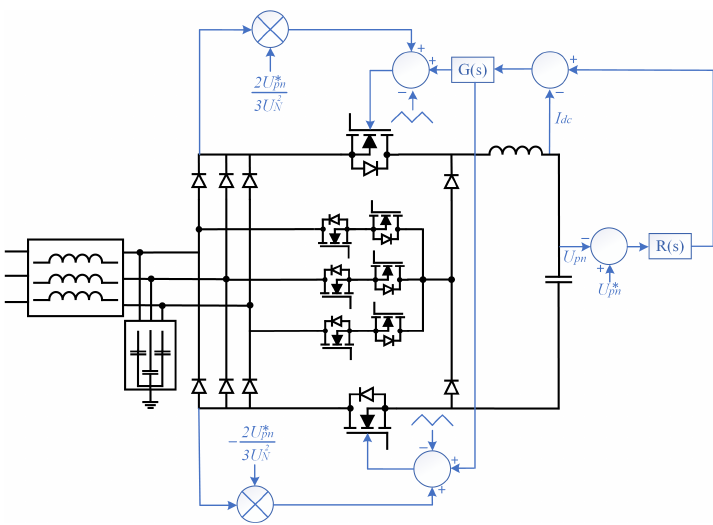
Figure 11. PWM control strategy for Swiss rectifier, edited from